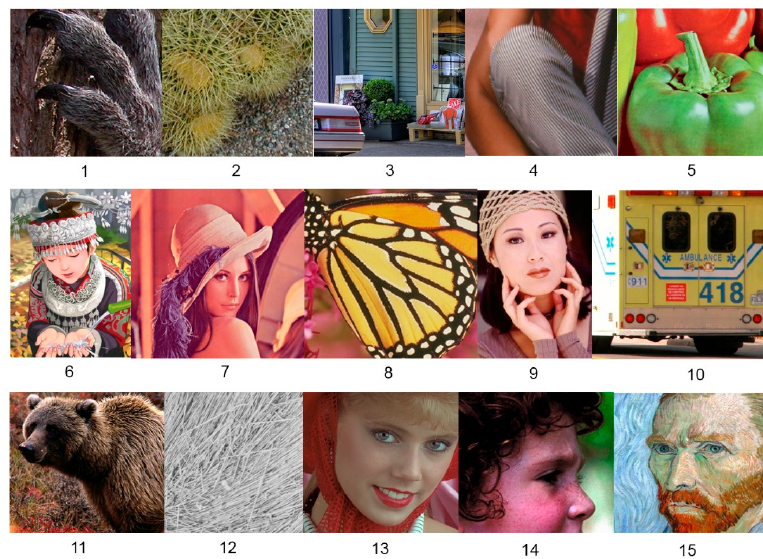
Figure 6. Small texture dataset.